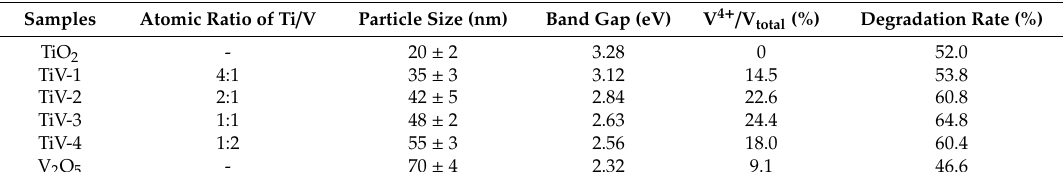
Table 1. Correlations of the atomic ratio of Ti / V, particle size, band gap, and the degradation rate of samples.